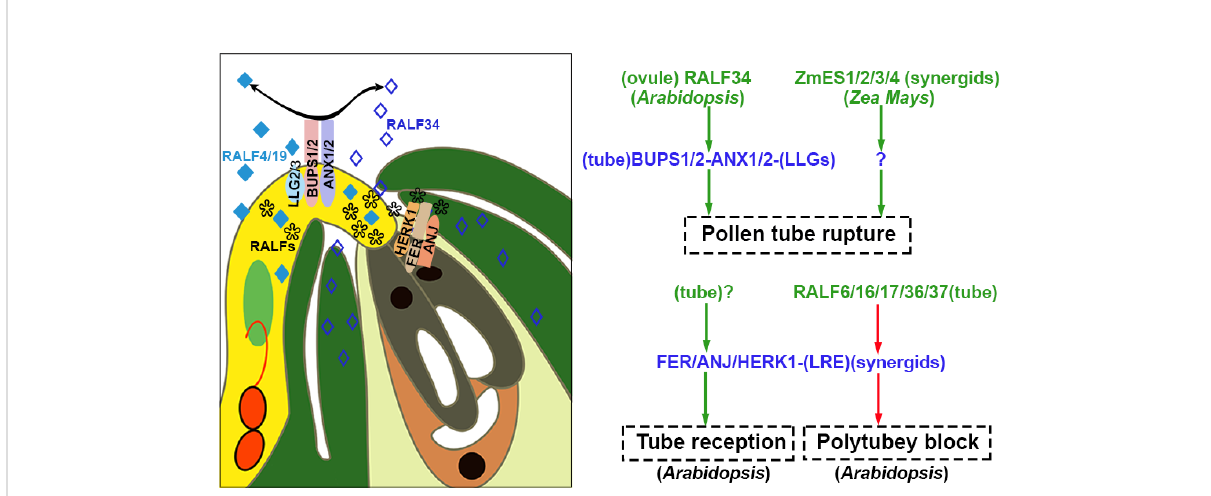
FIGURE 5 Pollen tube is received, polytubey block, and rupture. At the micropyle, FER/ANJ/HERK1-LLG1 derived from synergid cells is involved in the recognition and reception of pollen tube; they also interact with tube-speci fi c RALF6/16/17/36/37 to cause polytubey block. After the pollen tube enters the ovule, the interaction between ovule-speci fi c RALF34 and BUPS1/2-ANX1/2-LLGs of the pollen tube results in the rupture of the tube in Arabidopsis . ZmES1/2/3/4 secreted by synergids is related to the rupture of the pollen tube in Zea Mays . The peptides are highlighted in green and red to represent activation or suppression, respectively. The receptor complexes are marked in blue and the co-receptors are shown in parentheses. Question marks indicate unidenti fi ed signal components. The source of peptides and receptors is shown in parentheses. Abbreviations for all small peptides and receptors are elucidated in the